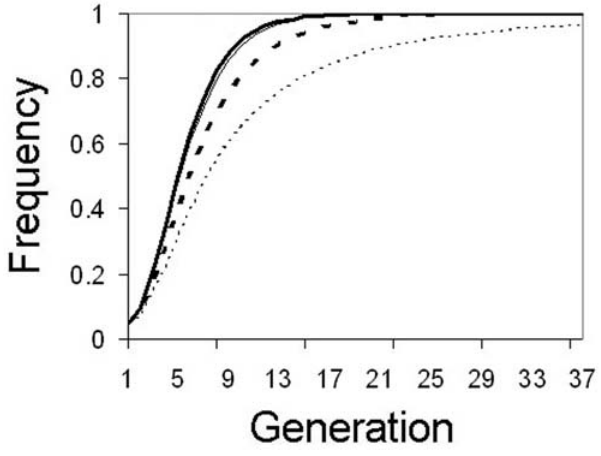
Figure 6. Passive transgene elimination. Changes in transgene frequency with a 5% discontinuous release every 10 generations of mosquitoes homozygous for a transgene at 4 unlinked loci (8 copies/ genome). Releases are halted after the fourth release. If transgenes are costly, selection eliminates the construct from the population. Thick solid line: no fitness cost ( F =1.0), thin solid line: 1% fitness cost/insert ( F =0.99), thin dotted line: 5% fitness cost/insert ( F =0.95).